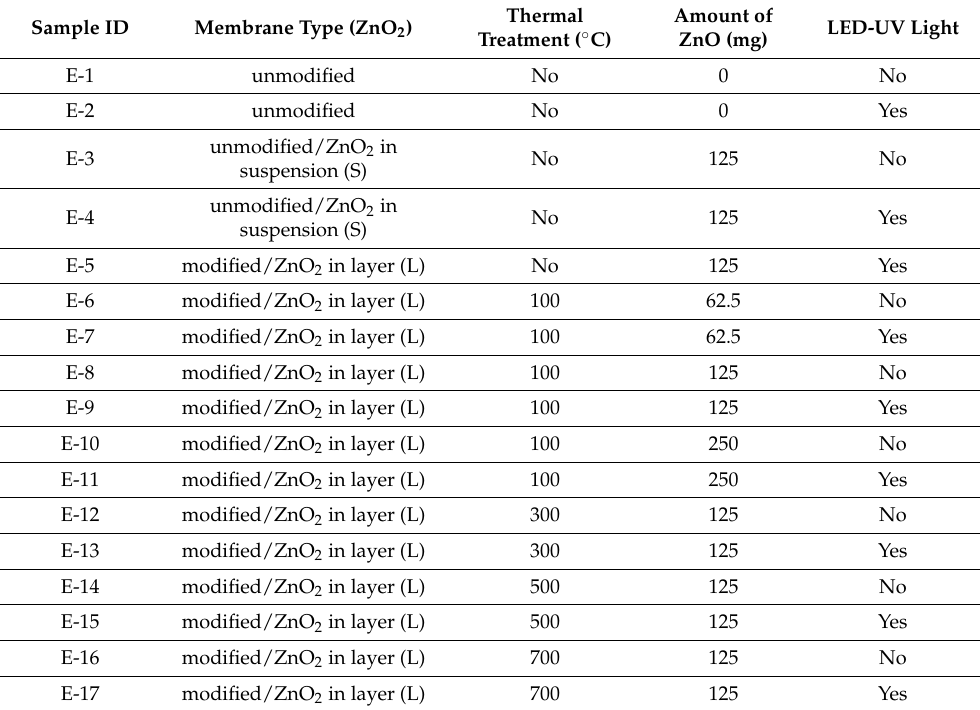
Table 1. Nomenclature used to characterize the different assays